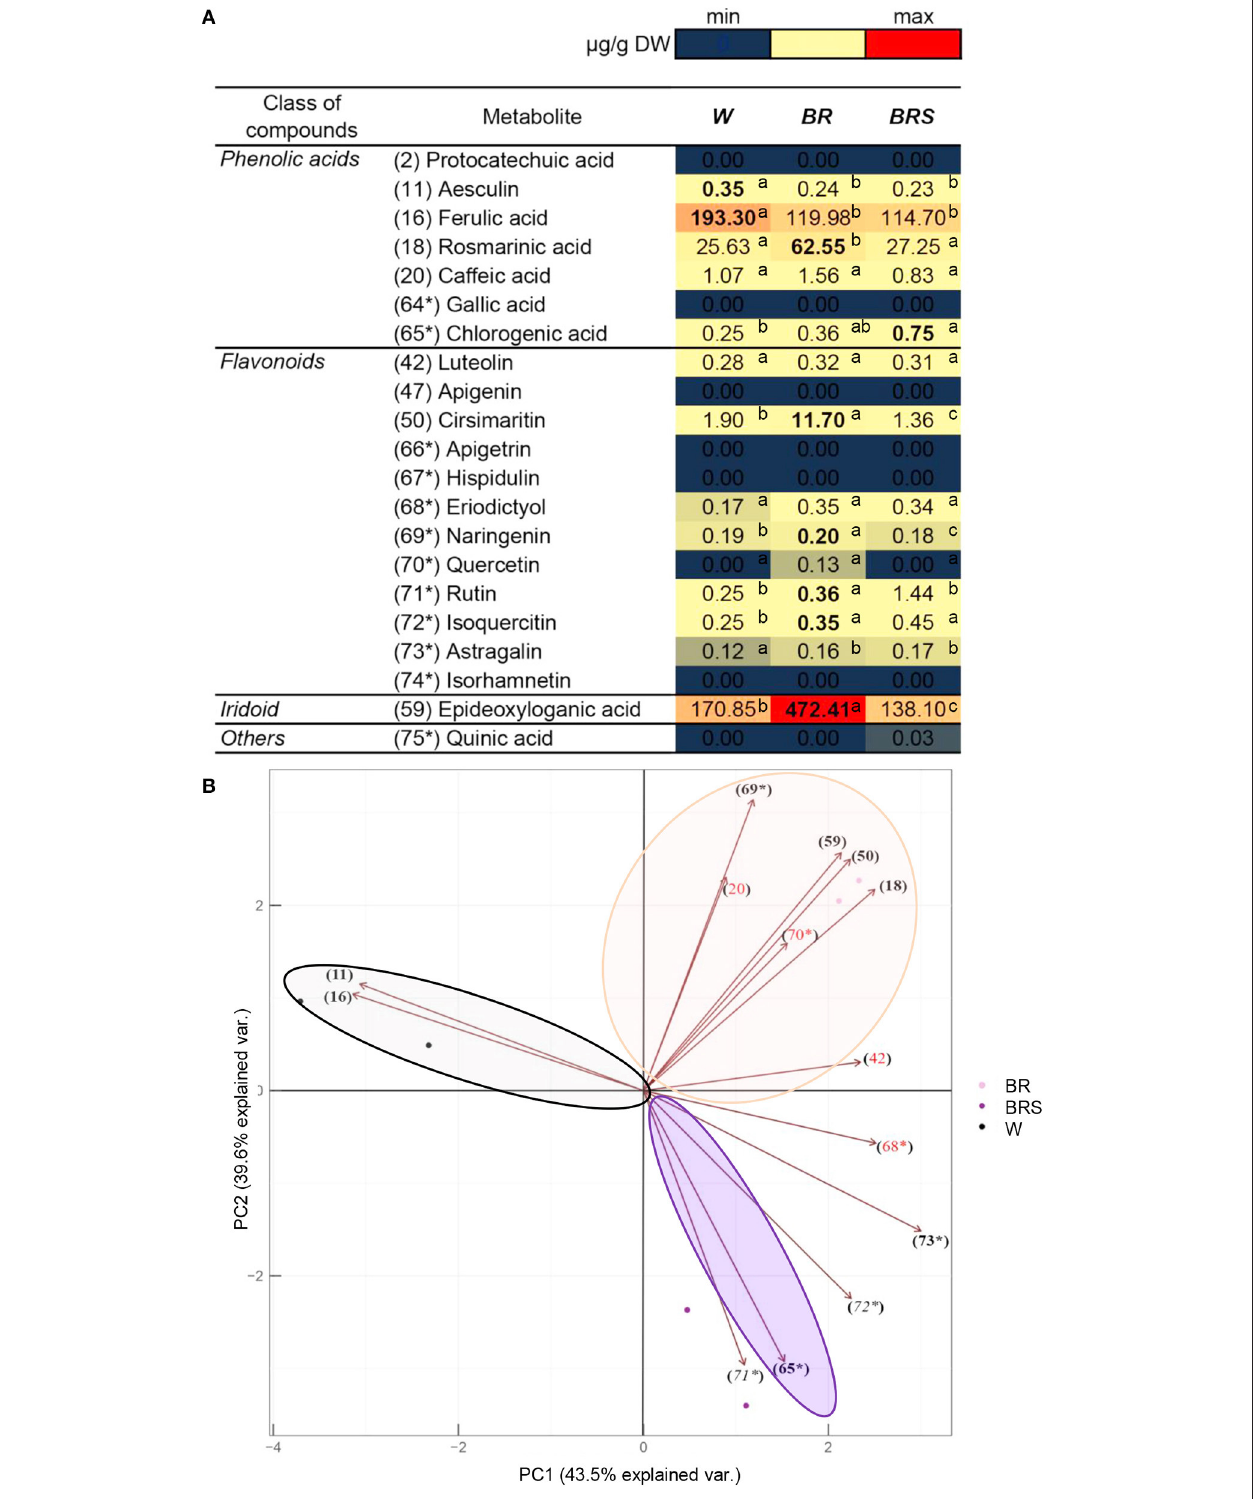
Frontiers in Plant Science |